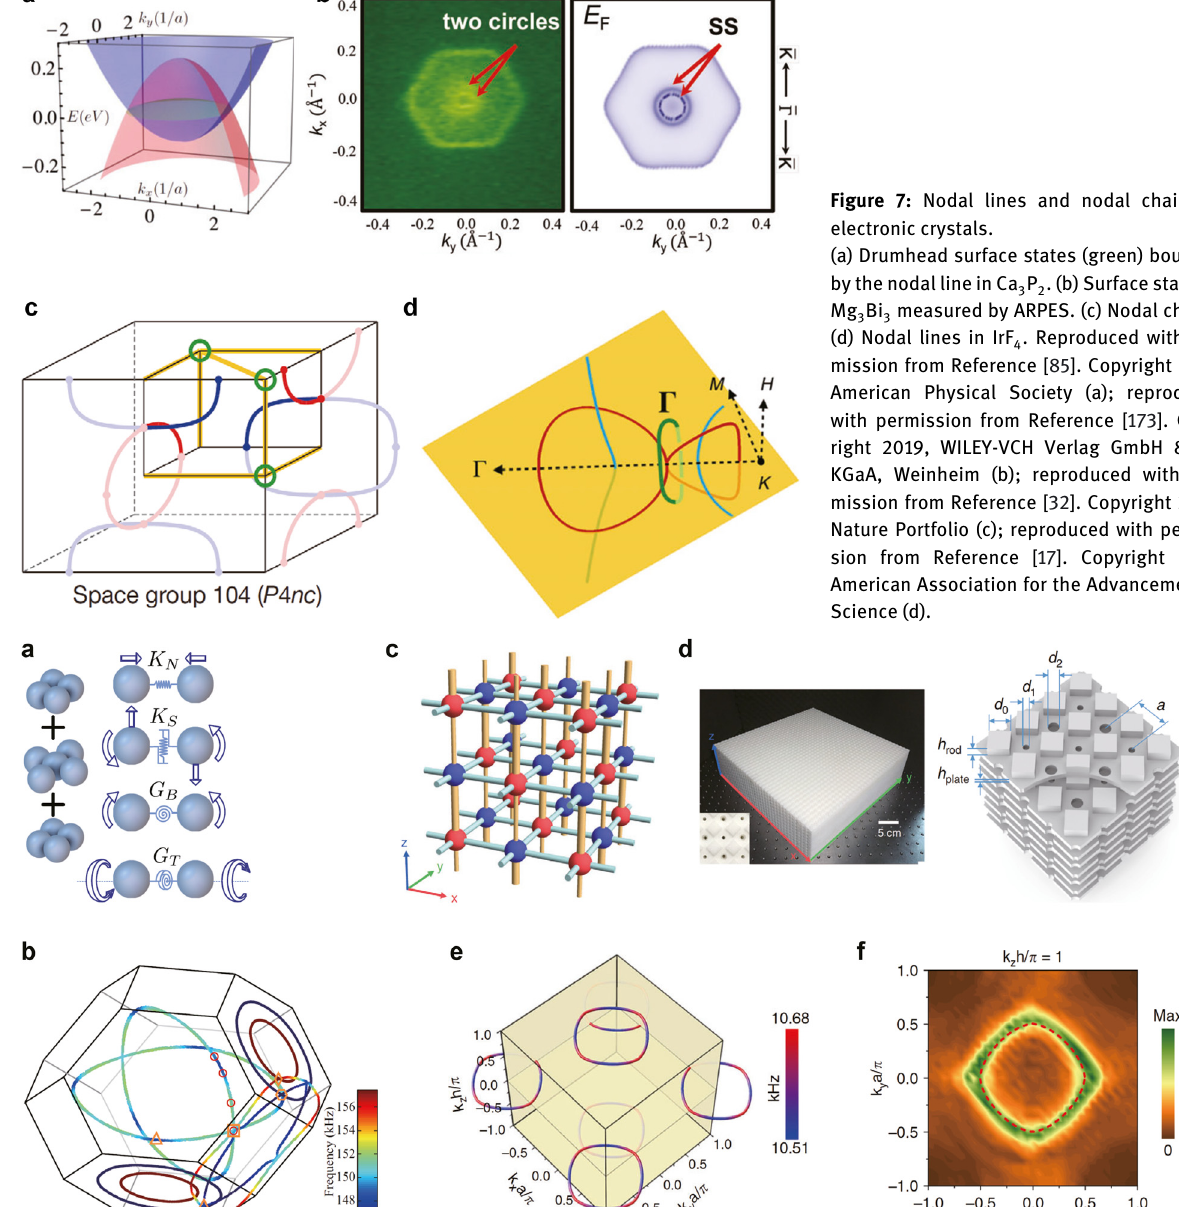
Figure 8: Nodal lines in phononic crystals. (a) Schematic of a granular metamaterial toward phononic nodal chain. Four types of interactions between two beads in the nearest-neighbors are also illustrated. (b). Simulation results showing the nodal chain in momentum space. (c) An illustration of the tight-binding Hamiltonian in Eq. (34) with different values of t and 𝛿 t . (d) Photograph (left) and schematics (right) of a phononic crystal exhibiting nodal rings. (e) and (f) Simulation and experimental results showing nodal rings, respectively. Reproduced with permission from Reference [97]. Copyright 2019, Nature Portfolio (c)–(f); Reproduced with permission from Reference [89]. Copyright 2019, Nature Portfolio